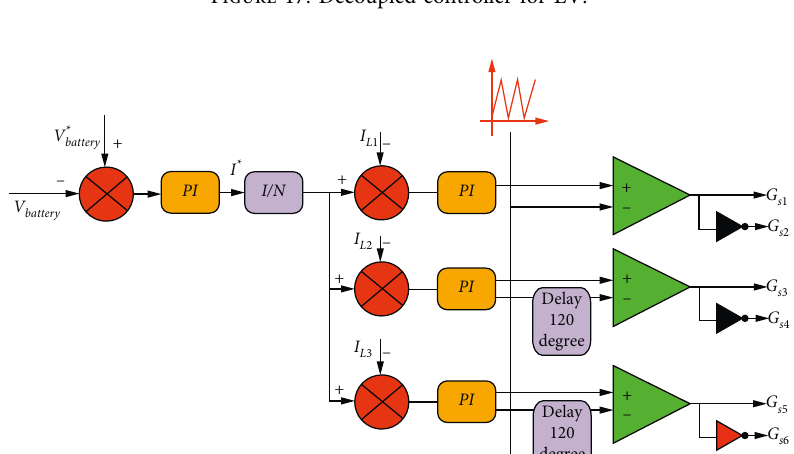
Figure 17: Decoupled controller for EV.